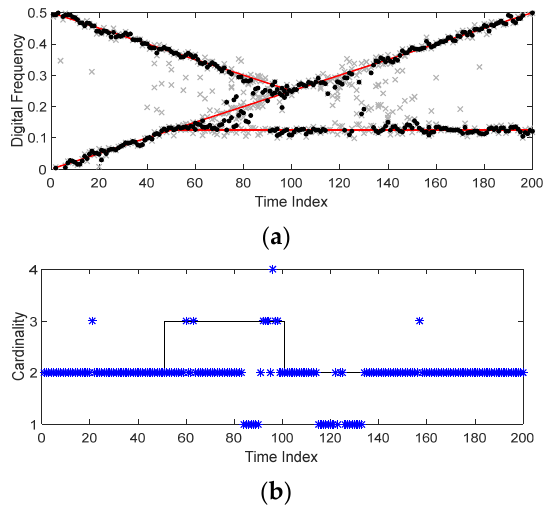
Figure 9. The result of the FCM_CPHD (case 2): ( a ) Frequency tracking; ( b ) Cardinality estimate.